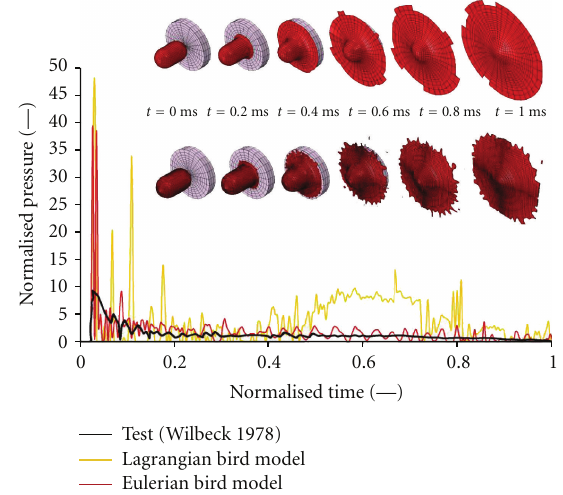
Figure 8: Validation of bird impactor models, impact on rigid plate: pressure-time-plots.